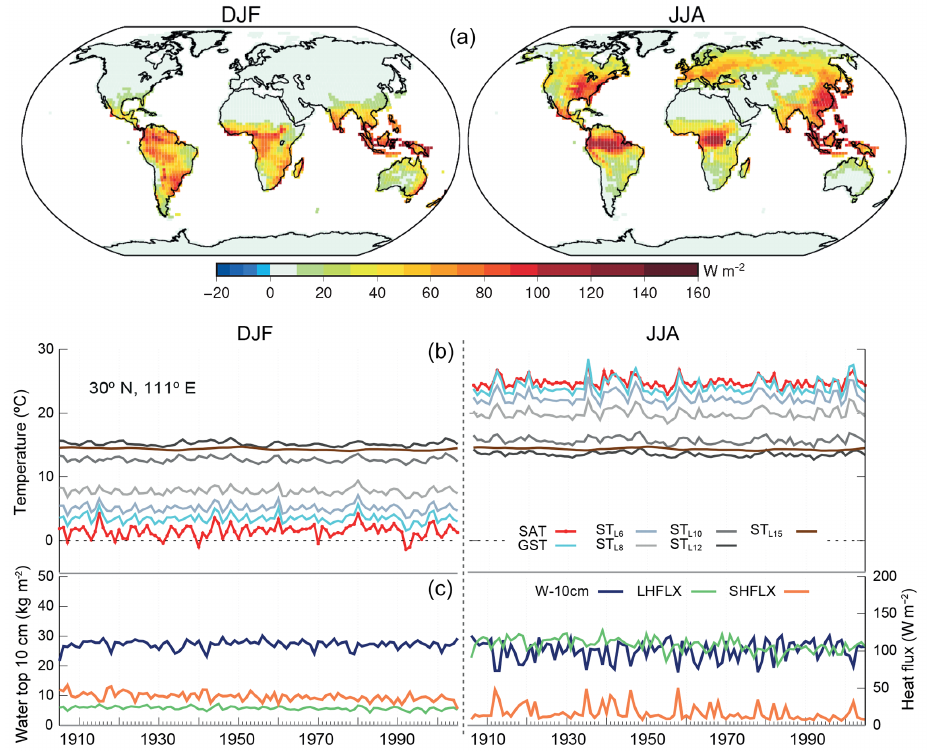
Figure 5. (a) DJF and JJA average surface latent heat fluxes (LHFLX) over the 850–2005CE period. (b) DJF and JJA time evolution of SAT, GST, ST L6 , ST L8 , ST L10 , ST L12 and ST L15 during the 1900–2005CE period for a grid point from the ALL- F 2 simulation (southeastern China, 31 ◦ N, 111 ◦ E). (c) Same for SHFLX, LHFLX and water content in the top 10cm of soil ( W −